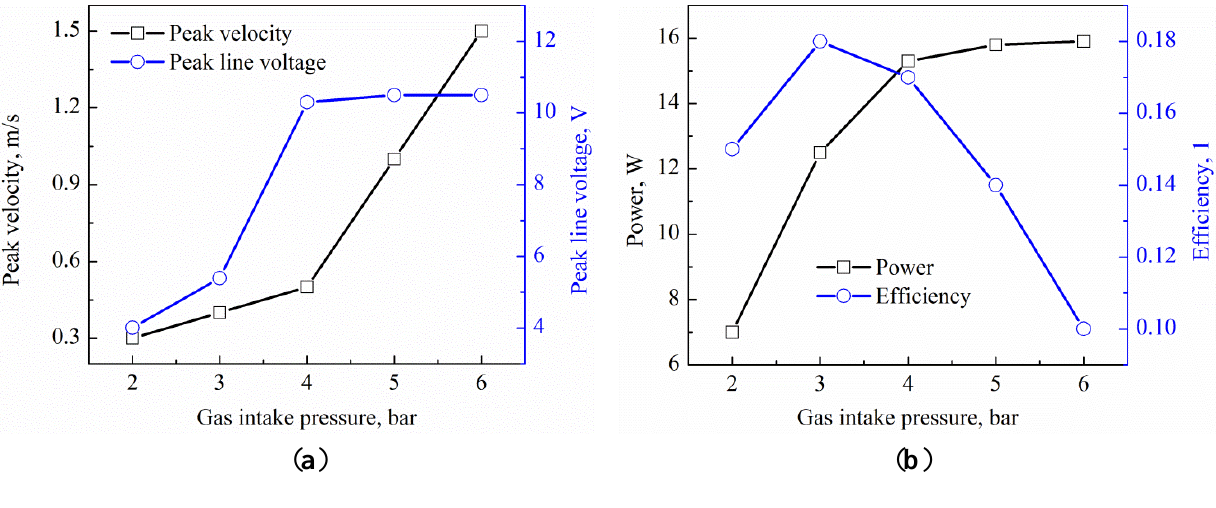
Figure 10. ( a ) The peak velocity and peak line voltage at different intake pressures; ( b ) The generating power and efficiency at different intake